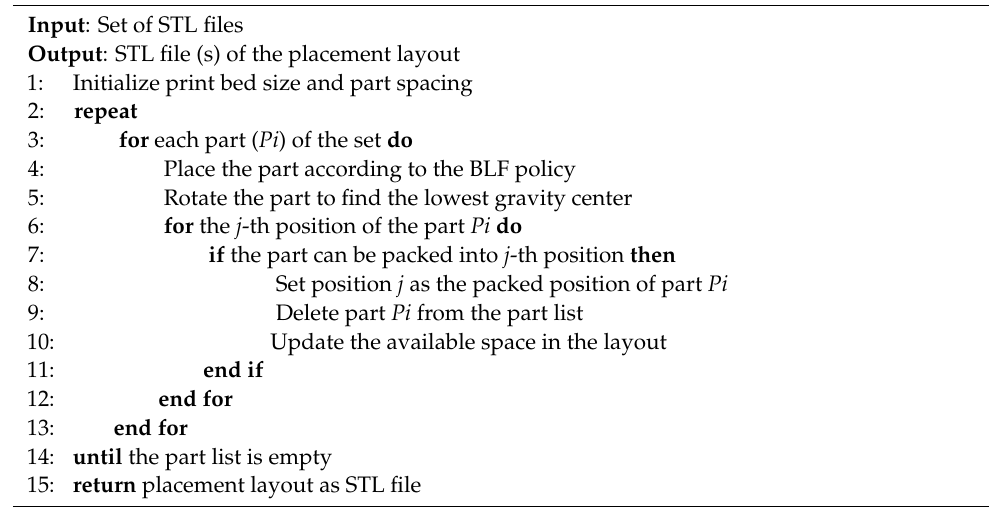
Algorithm 3: Pseudocode for the improved-BLF packing